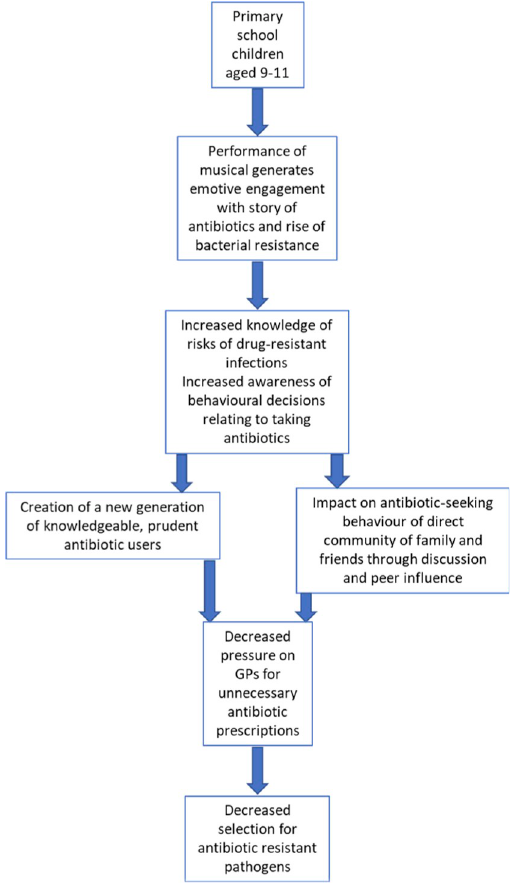
Fig 1. Pathway to impact on antimicrobial resistance through raising awareness in